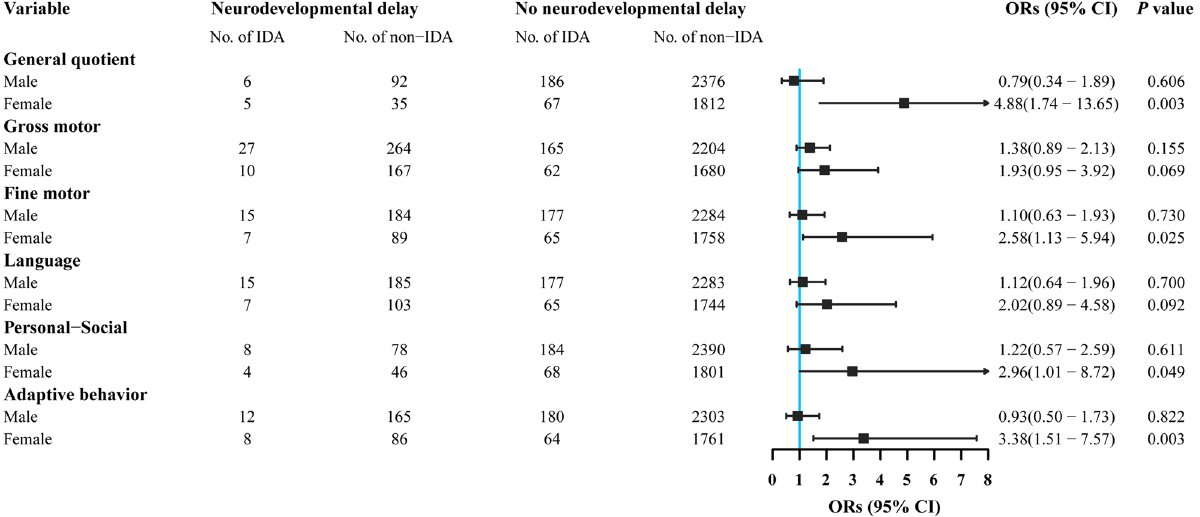
Figure 3. Associations between IDA (serum ferritin < 12 ng/mL and hemoglobin < 110 g/L) and neurodevelopmental delays for males and females. The ORs were adjusted for maternal education, parity, feeding at six months, infant age, height, and weight. IDA, iron deficiency anemia; ORs, odds